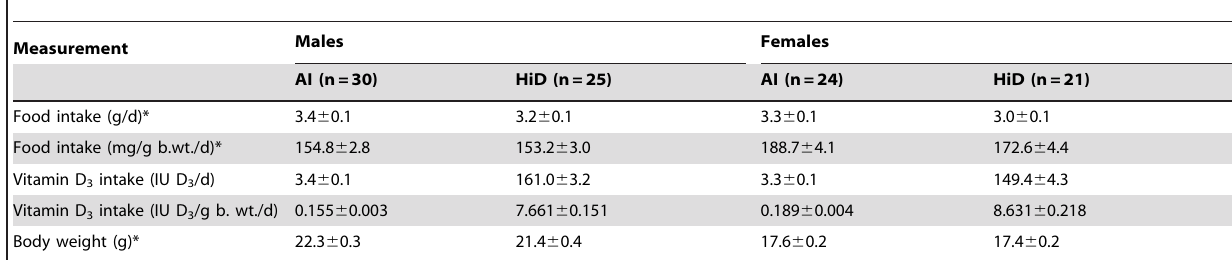
Table 2. Food intake, vitamin D 3 intake and body weight of G93A mice.